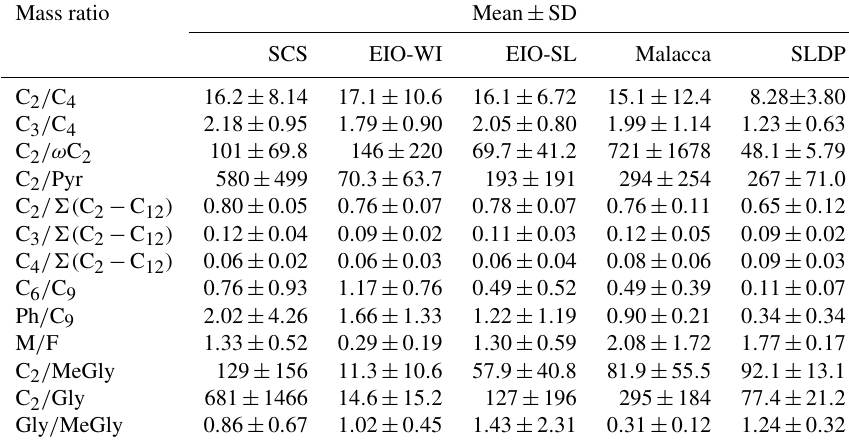
Table 3. Diagnostic mass ratios of selected diacids and related compounds in TSP samples collected during the NORC2015-10